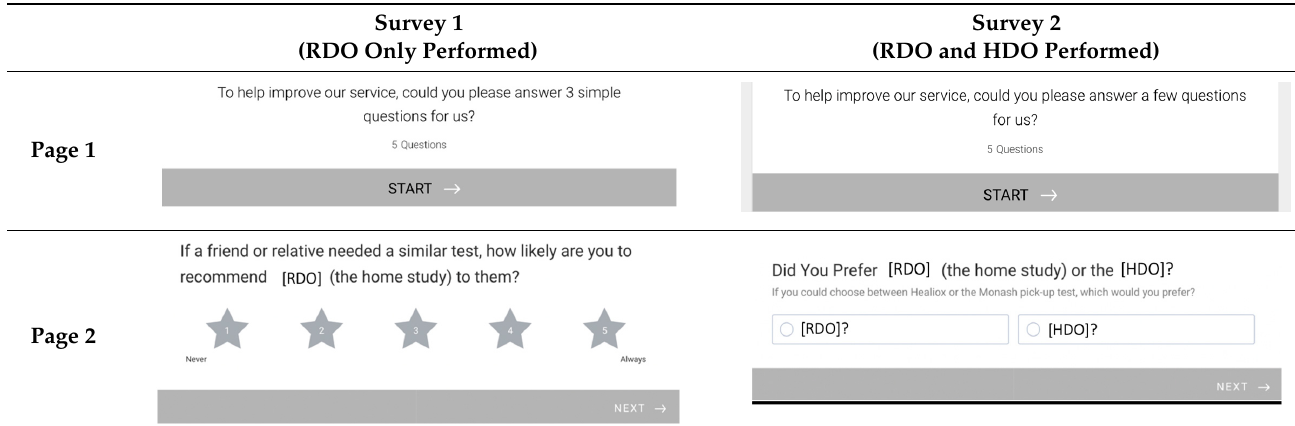
Table 1. Follow-up surveys: The follow-up surveys sent to patients during the trial are shown. Survey 1 was sent after the patient completed the RDO. Survey 2 was sent after the patient had completed both the RDO and HDO. However, as the COVID-19 pandemic progressed, appointments for the HDO were delayed or cancelled. Therefore, questions shown in “Page 4” and “Page 5” for Survey 2 were added, and Survey 2 was sent to patients regardless of completion of the HDO.